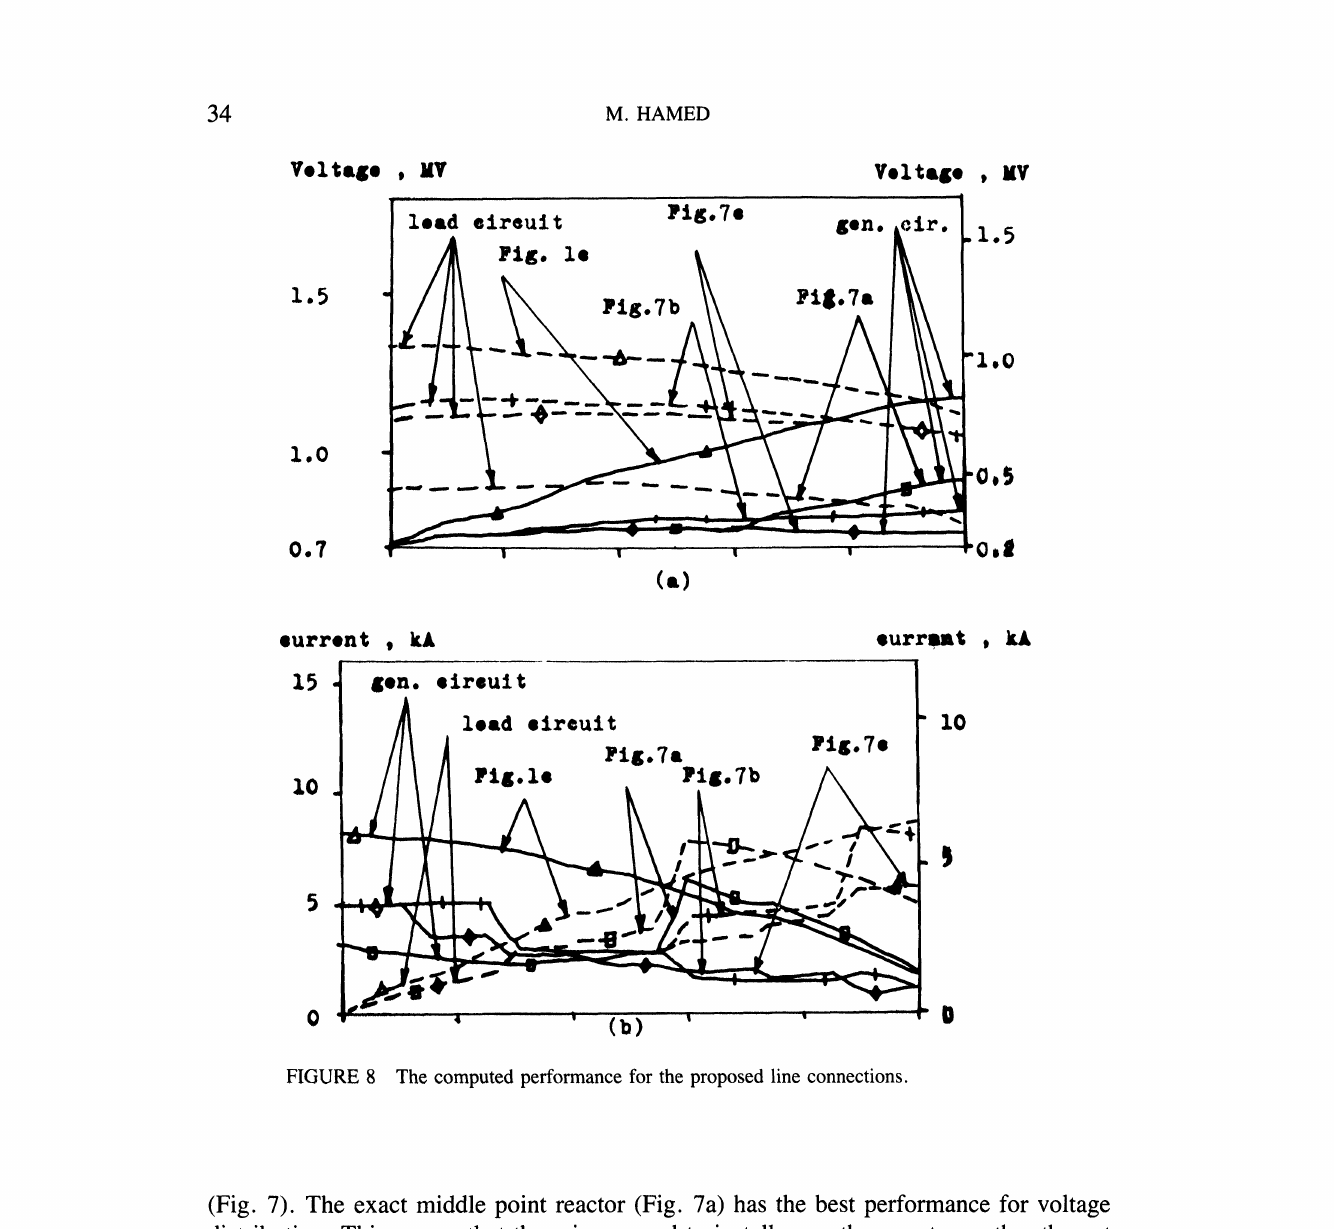
FIGURE 8 The computed performance for the proposed line